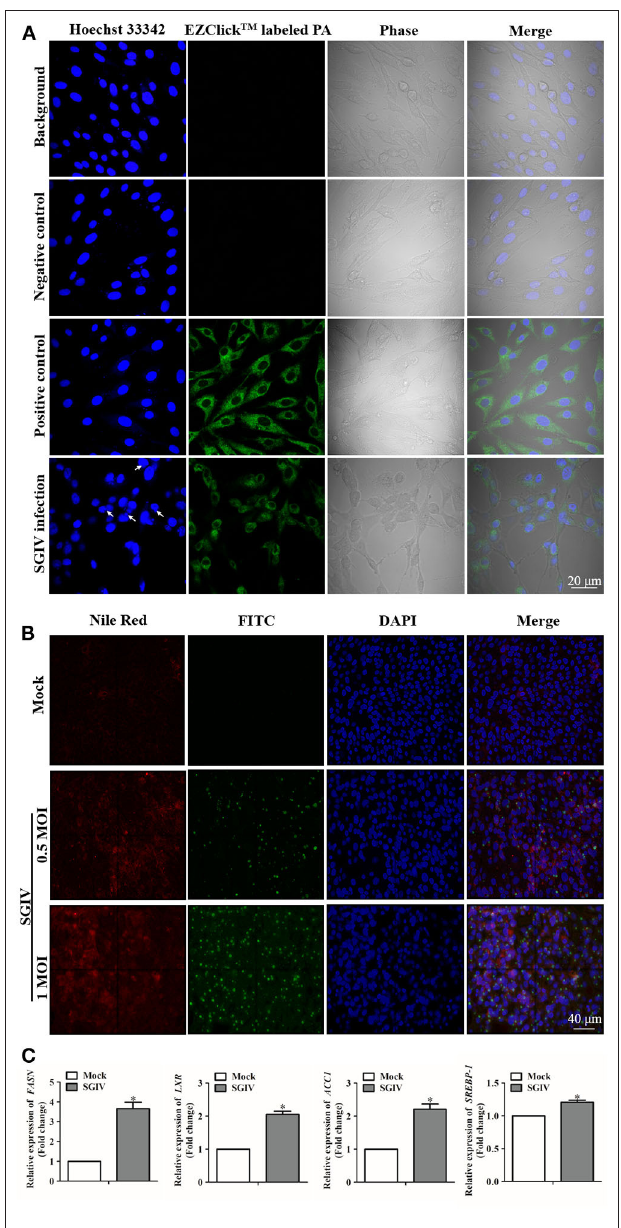
FIGURE 1 | Lipids were involved in fish virus infection. (A) Intracellular palmitic acid accumulation analysis using EZClick TM Palmitoylated Protein Assay. The green fluorescence generated by EZClick TM Palmitic Acid was observed under the fluorescence microscope (Zeiss), and viral assembly sites are indicated by arrows. (B) Nile red staining of the intracellular lipids with and without SGIV infection and immunofluorescence assay carried out at the same time with the anti-SGIV-MCP antibody. The red fluorescence represents the accumulation of lipids, and green fluorescence is for SGIV-MCP. Fluorescence signals were observed under the fluorescence microscope (Zeiss). (C) Evaluation of the mRNA transcription levels of fatty acid synthesis related genes after SGIV infection. GS cells were infected with SGIV (MOI: 0.5), the mRNA transcriptional levels of fatty acid synthesis related genes were evaluated by qRT-PCR at 12h post-infection. The data are represented as mean ± SD, and the statistical significances were determined with Student’s t -test, n = 3. The significance level was defined as * p <